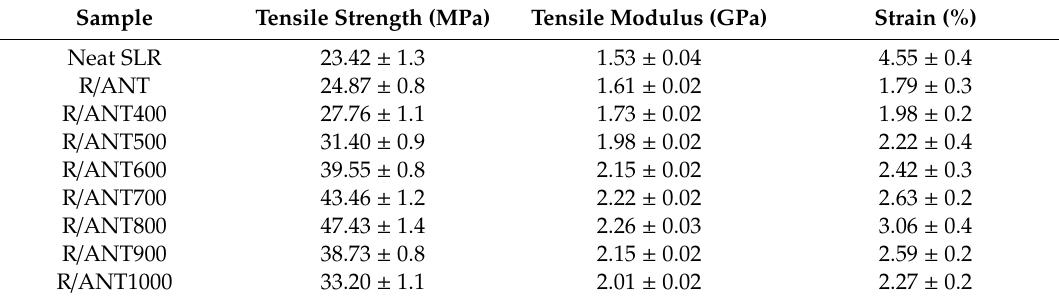
Table 1. Extracted results of tensile strength, tensile modulus, and % strain of 3D printed samples of pure SLR and SLR / nanofillers